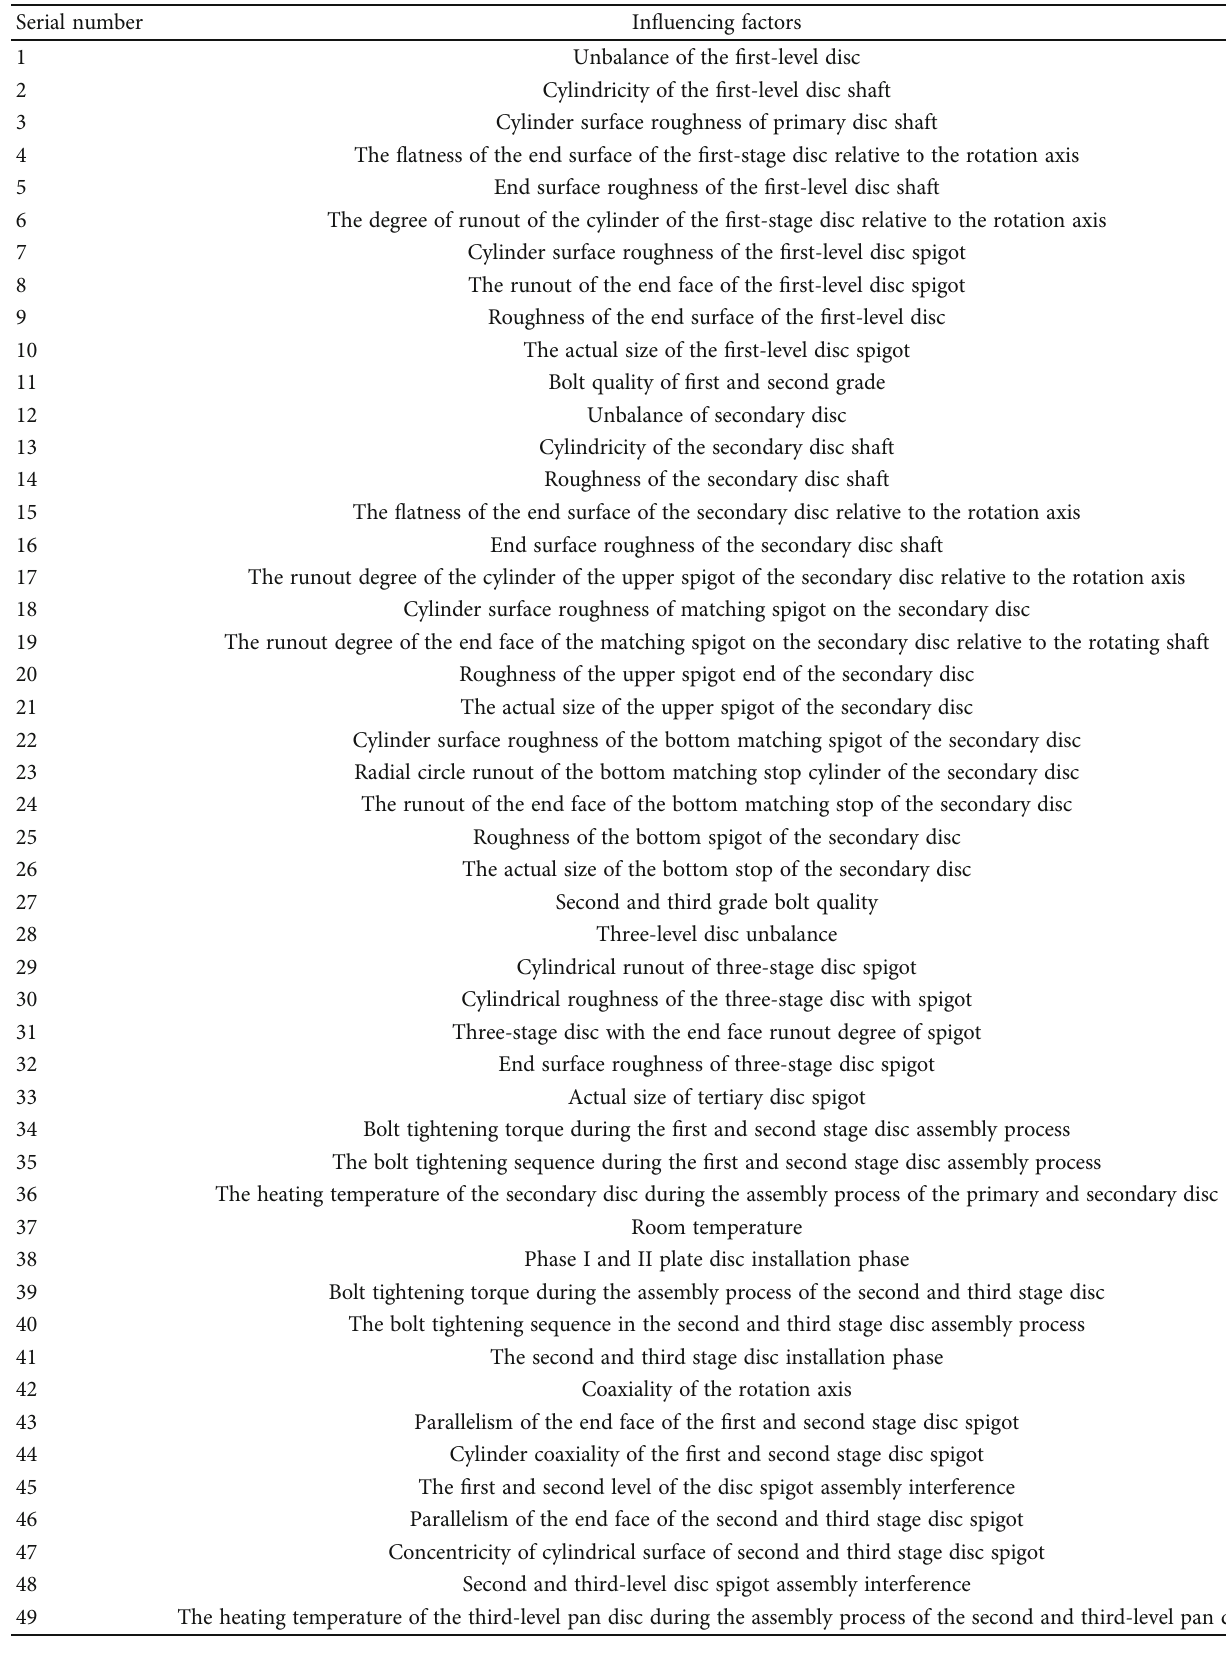
Table 12: Disc assembly process unbalance in fl uence factor